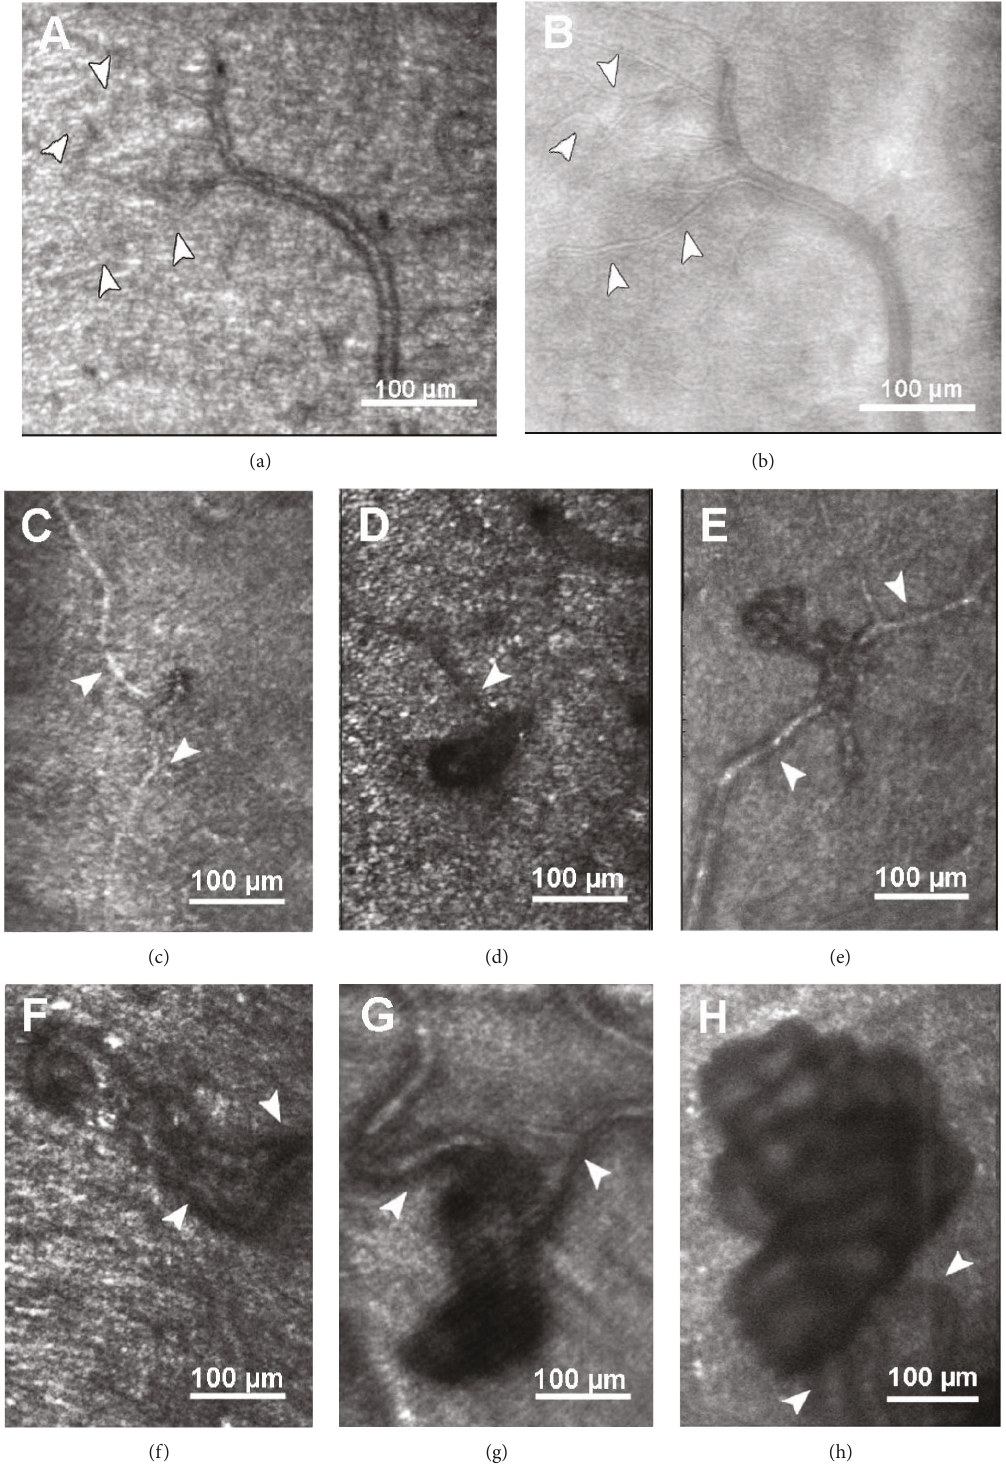
Figure 1: (a) Example of an arteriole in confocal and multiply scattered light (MSL) and (b) AOSLO imaging. Finer details of the vessel walls are visualized with MSL AOSLO imaging, which increases the sensitivity to scattered light re fl ected from vasculature and erythrocytes. (c – f) Intraretinal microvascular abnormalities (IRMA). (g, h) Neovascular proliferations (NVE) growing anteriorly to the RNFL. Arrowheads indicate feeder/draining vessels. In (d), the AOSLO image is focused at the photoreceptor level and displays a regular photoreceptor mosaic surrounding the blurred shadow of an IRMA. In (g) and (h), the 3-dimensional structure of the NVE results in clear focus on some vascular loops and blurry vessel formations in other areas of the